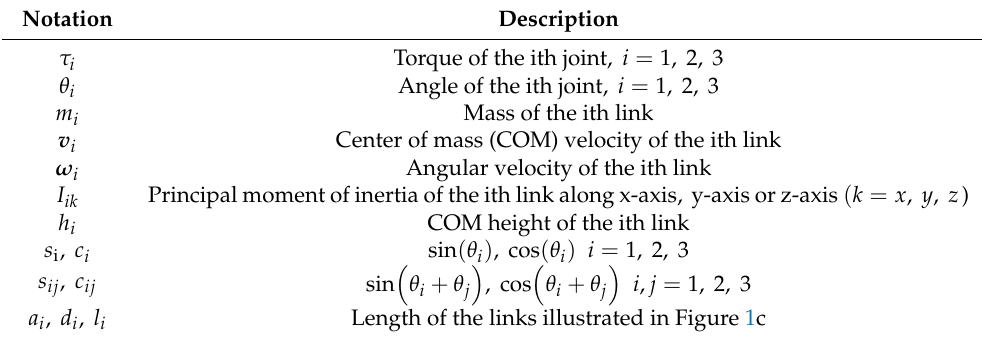
Table A1. Notations of the dynamic